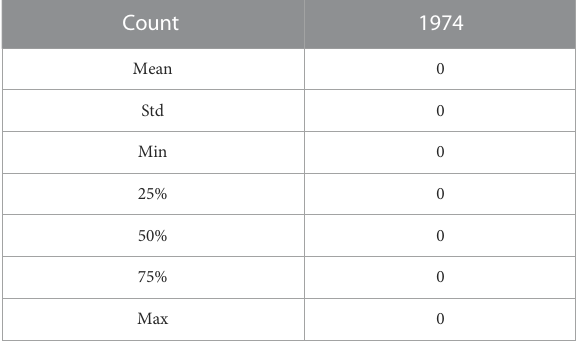
TABLE 3 Descriptions of null-valued columns (e.g., nB).